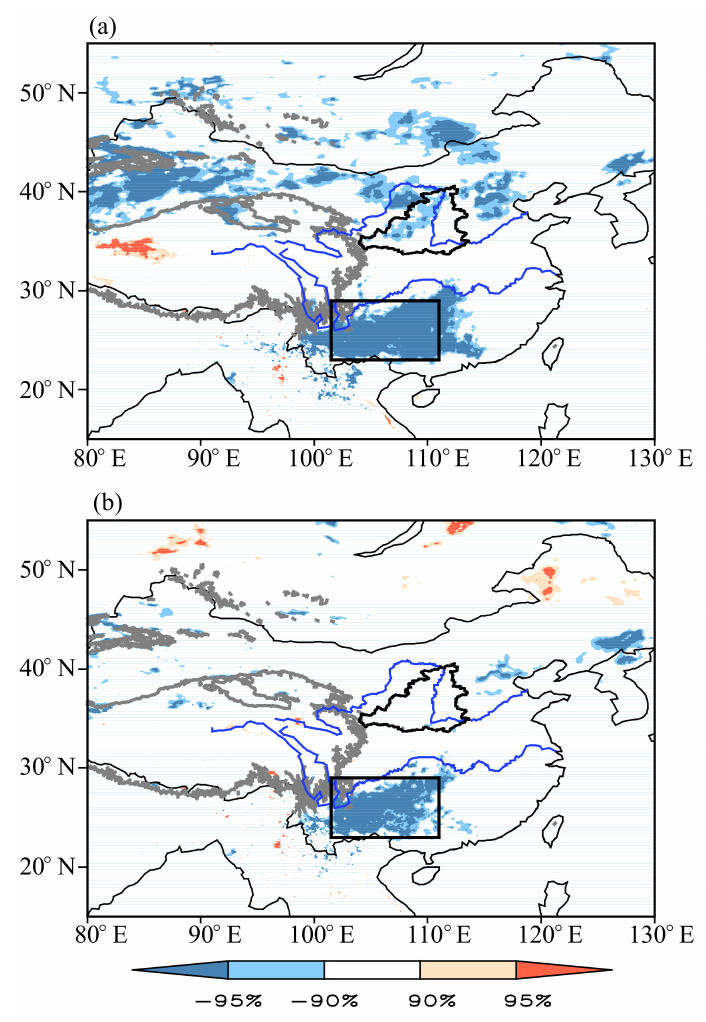
Figure 3. ( a ) Distribution of correlation coefficients between the September observational MRYR precipitation index and the preceding July–August SMs during the period 1979–2021; ( b ) As in ( a ), but for that on interannual time scales. Shadings denote the correlation significant at the 90% and 95% confidence levels, as shown by the color bars. The black bold borderline around the Yellow River (the blue curve in northern China) represents the MRYR region and the thick gray contour denotes the Tibetan Plateau (3000 m above sea